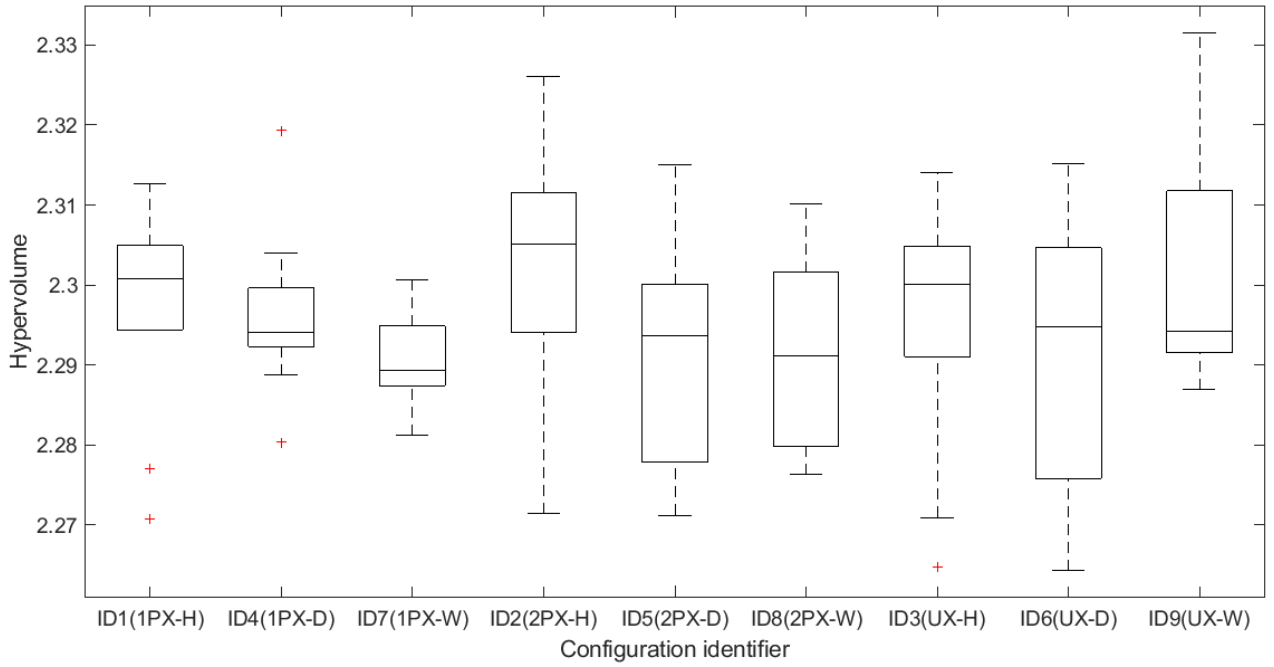
Figure 5. Box plots of the final Hypervolume (accuracy